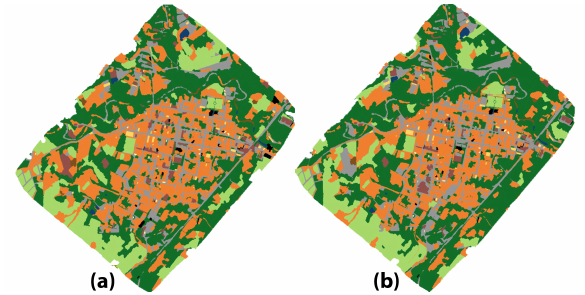
Figure 6. Random Point Cloud over the ground-truth The classification accuracy is assessed by comparing the intersection among the points of the ground-truth and the classified image. After that, the confusion matrix is calculated, computed.